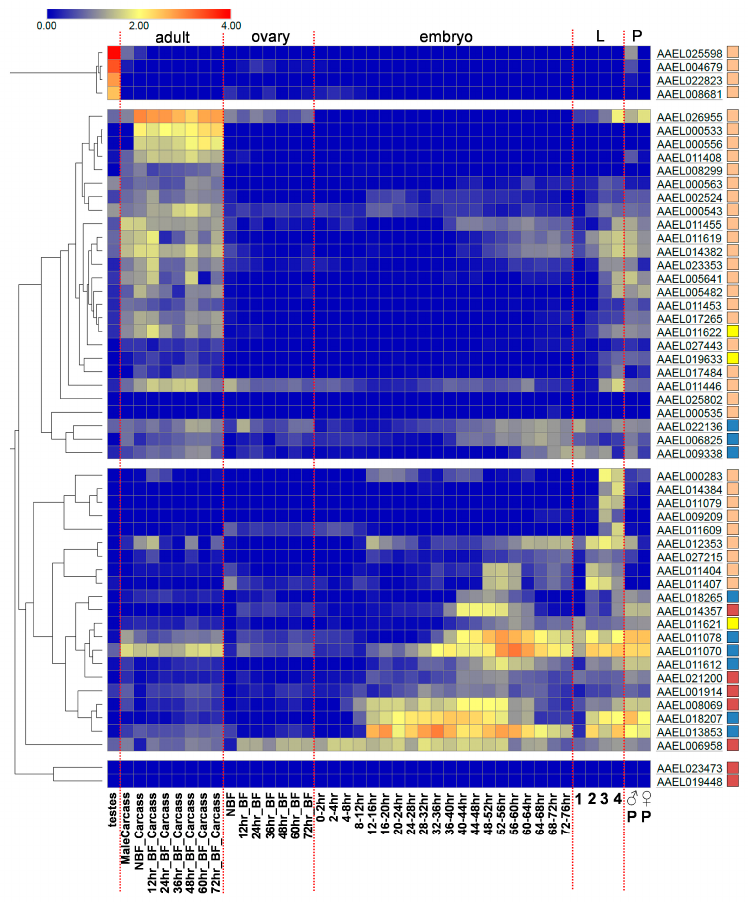
Figure 2. Developmental expression of A. aegypti mRNA transcripts encoding CTLDcps. Color indicates the log10 FPKM expression value. No scaling is applied to rows; clustering was performed using Morpheus (https://software.broadinstitute.org/morpheus) with one minus pearson correlation and average linkage. CTLD-S ( ■ ), -SP ( ■ ), -E ( ■ ), and -X ( ■ ) groups are indicated. NBF, non-bloodfed; BF, bloodfed; L, larvae; P, pupae.